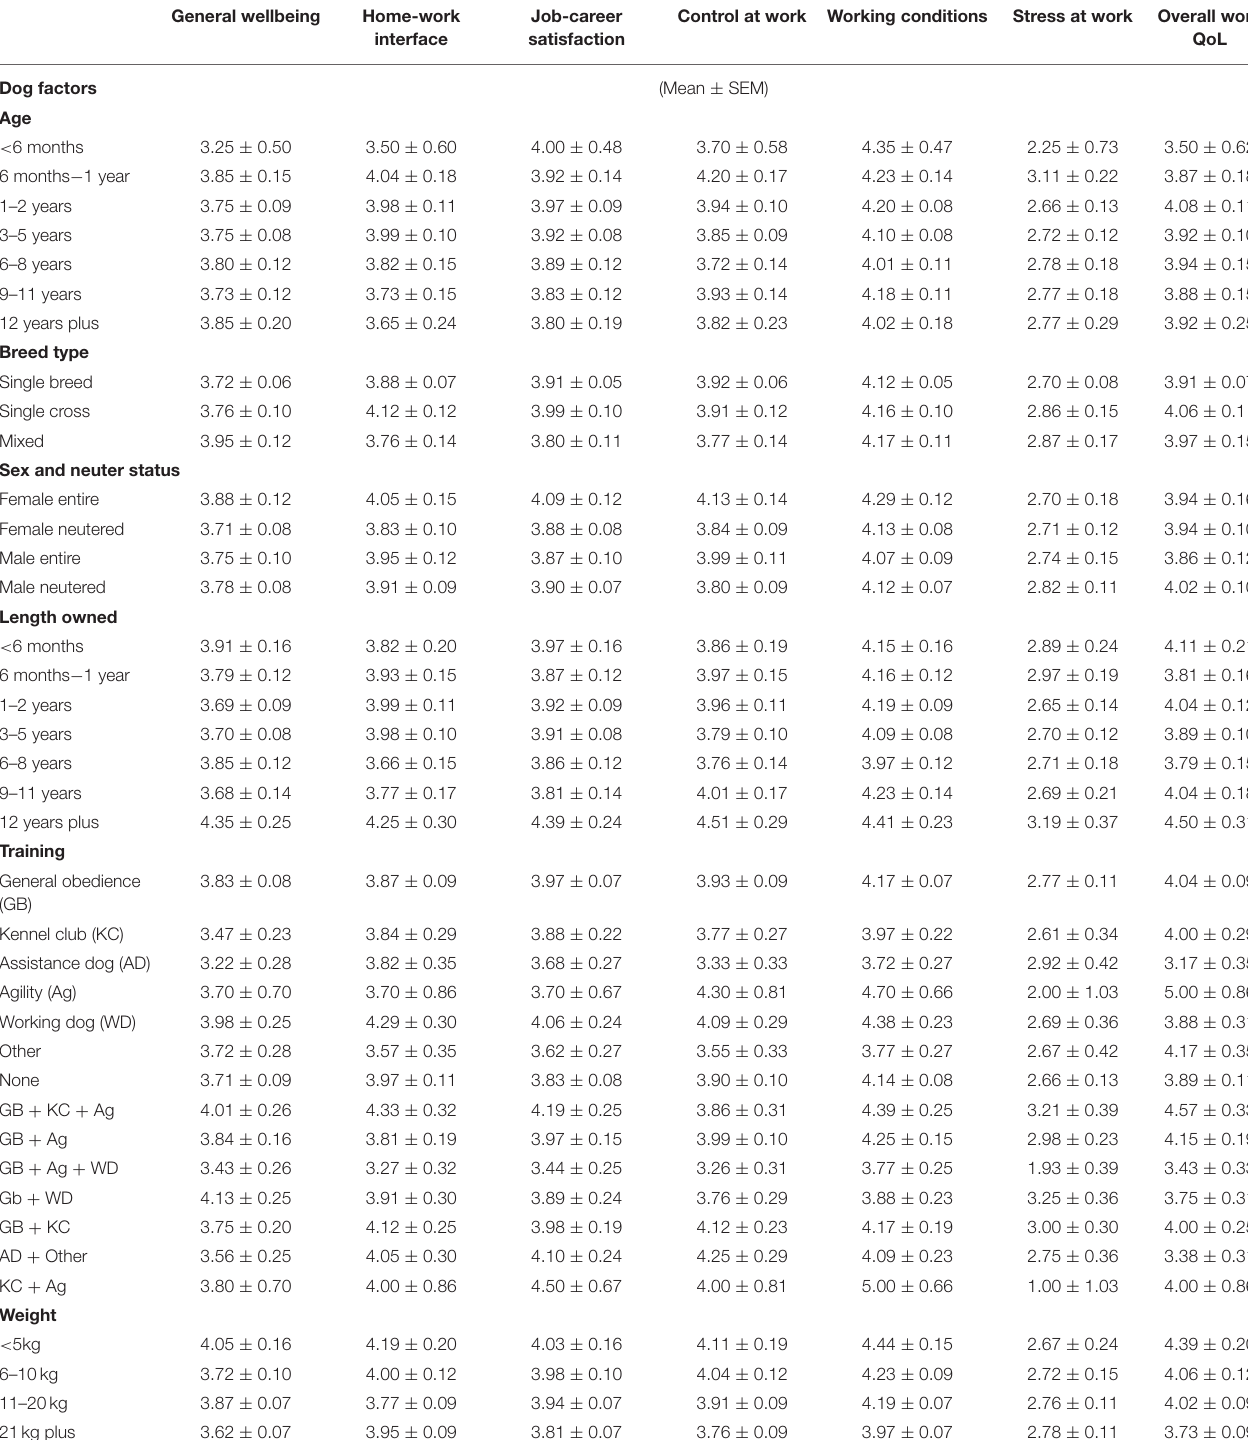
TABLE 5 | Descriptive statistics for work related quality of life in employees who take their dog to their office as a function of dog-based demographics. General